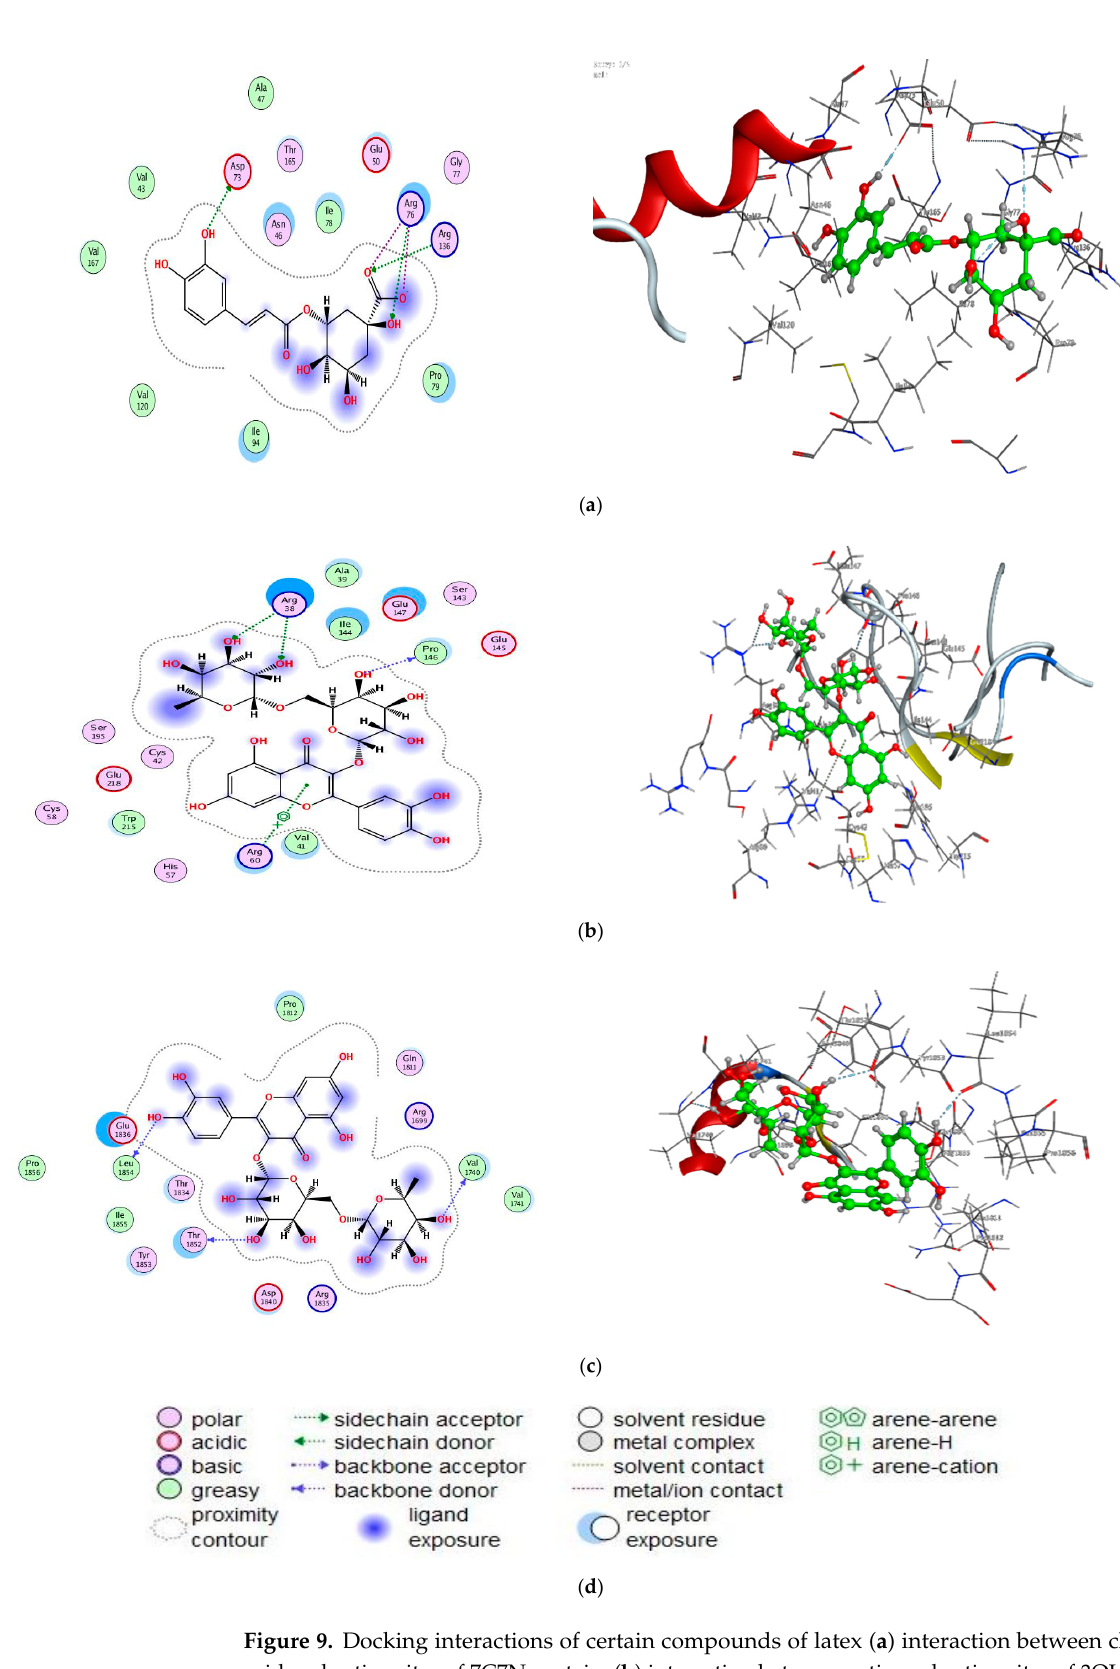
Figure 9. Docking interactions of certain compounds of latex ( a ) interaction between chlorogenic acid and active sites of 7C7N protein, ( b ) interaction between rutin and active sites of 3QUM protein, ( c ) interaction between rutin and active sites of 1JNX protein. ( d ) representative key for the types of interaction among rutin, chlorogenic acid, and